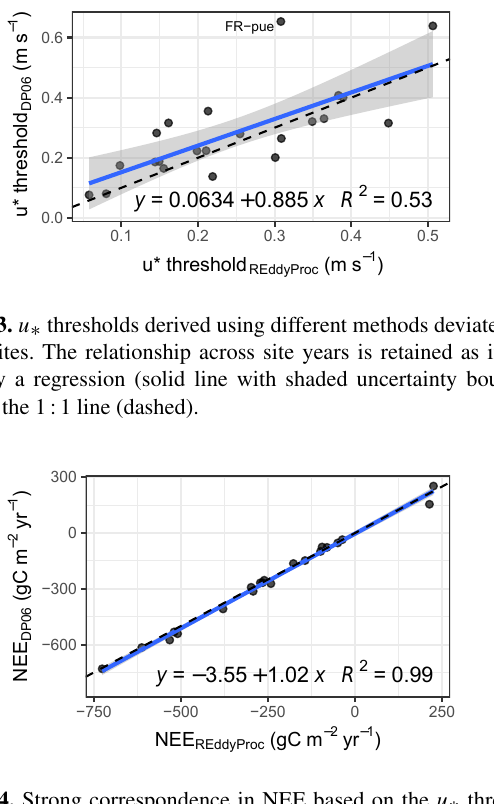
Figure 4. Strong correspondence in NEE based on the u ∗ thresh- old estimated by REddyProc and NEE based on the u ∗ threshold estimated by DP06 across site